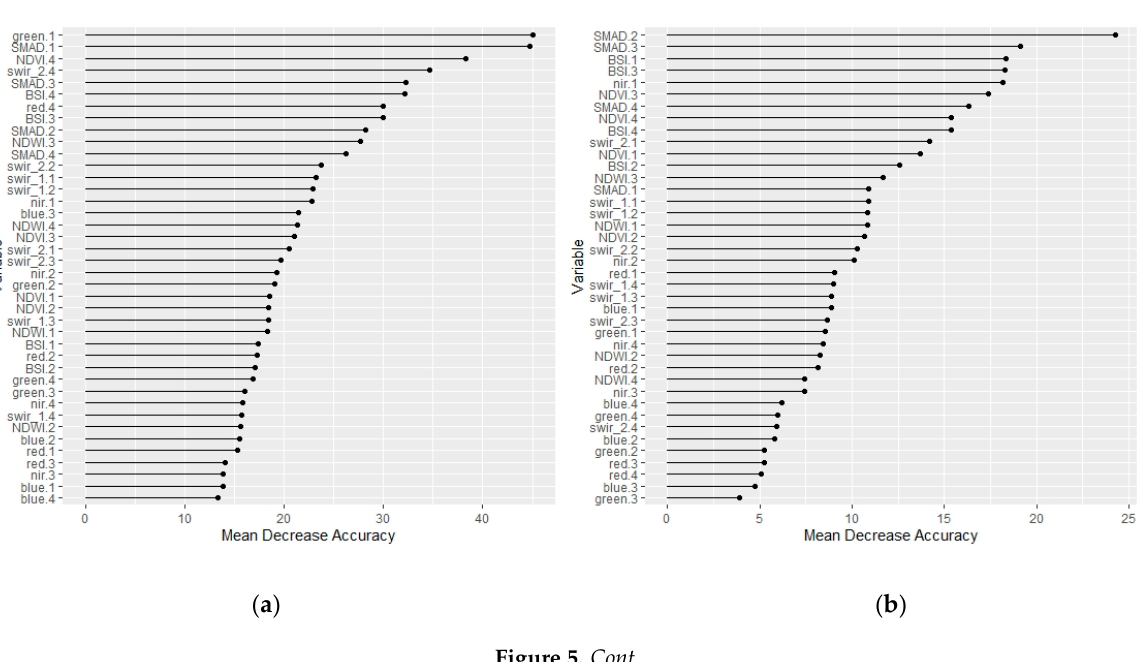
( c ) Figure 5. Variable importance expressed as mean decrease in accuracy for the stacked quarter datasets where the digit following each variable represents the quarter (1= January–March, 2 = April–June, 3 = July–September, 4 = October–De- cember) for ( a ) Silalatshani, ( b ) Nabusenga, and ( c ) Lungwalala. 3.4. Comparison to Existing Products Comparing the classification results detailed in Table 4 and Figure 3 with existing irrigated land maps illustrates differences in accuracy and resolution. Figure 6 compares the classified image of ORIA predicted on the random forest classification model for the annual Digital Earth Australia products with the Global Map of Irrigated Areas. Notably, this map product classified none of the Matabeleland sites as irrigated. Instead, the Mata- beleland sites are compared with the WaPOR land use classification product for the Afri- can continent (Figure 6).